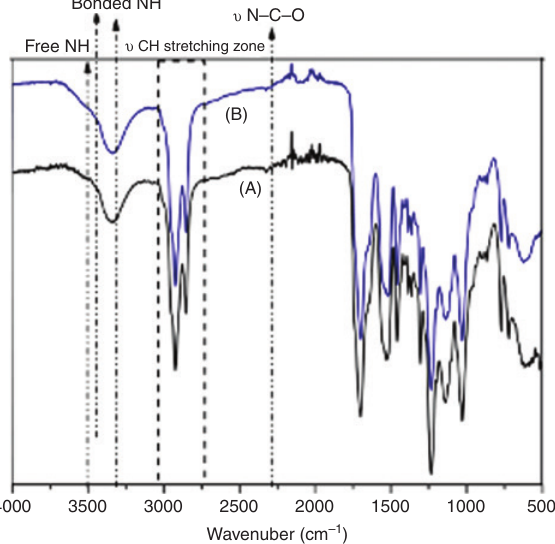
Figure 3: Infrared spectra of waterborne polyurethane (PU) prepoly- mer (A) WPUDCO-1 and (B) WPUDCO-2 4000–500 cm − 1 along with their characteristic bands.